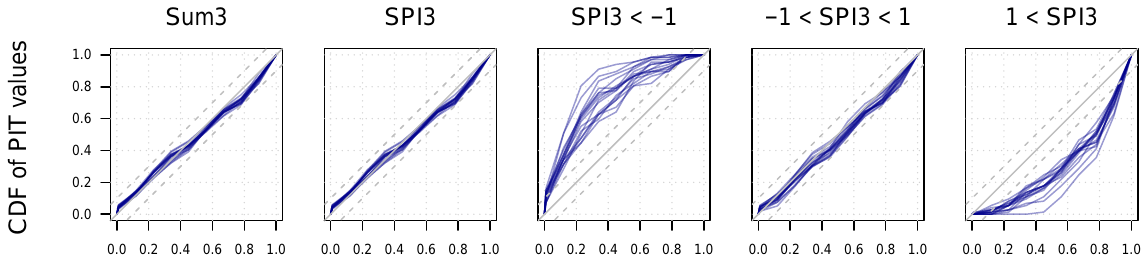
Figure 3. Reliability of SPI forecasts and forecasts of cumulative precipitation produced from bias corrected System 4 precipitation forecasts. PIT diagrams are presented for statistics calculated over the first 3 months altogether (Sum3 and SPI3). Columns correspond to scores computed for sums, SPI values, SPI values smaller than − 1 (dry), SPI values within − 1 and 1 (normal) and SPI values greater than 1